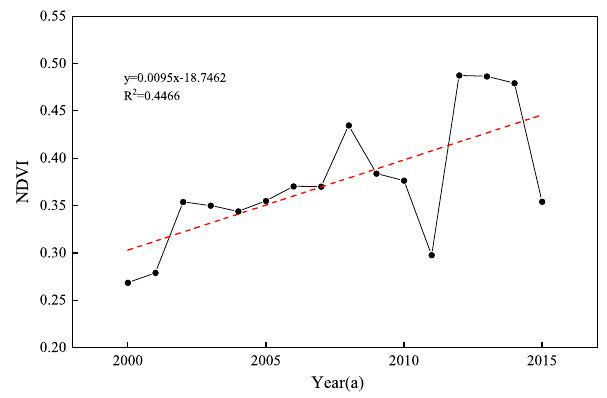
Fig. 8 Inter-annual variability of NDVI in Huangfuchuan River basin from 2000 to 2015